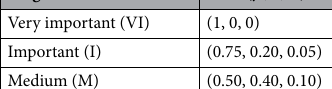
Linguistic variables